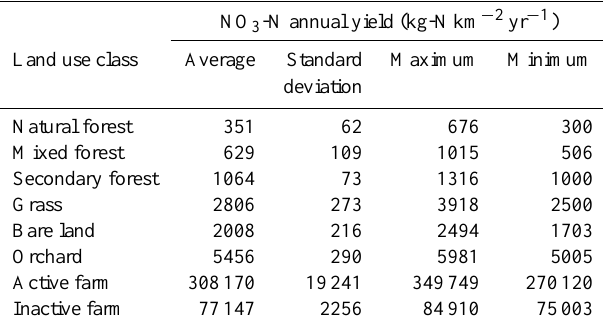
Table 8. The annual NO 3 -N yield for each land use